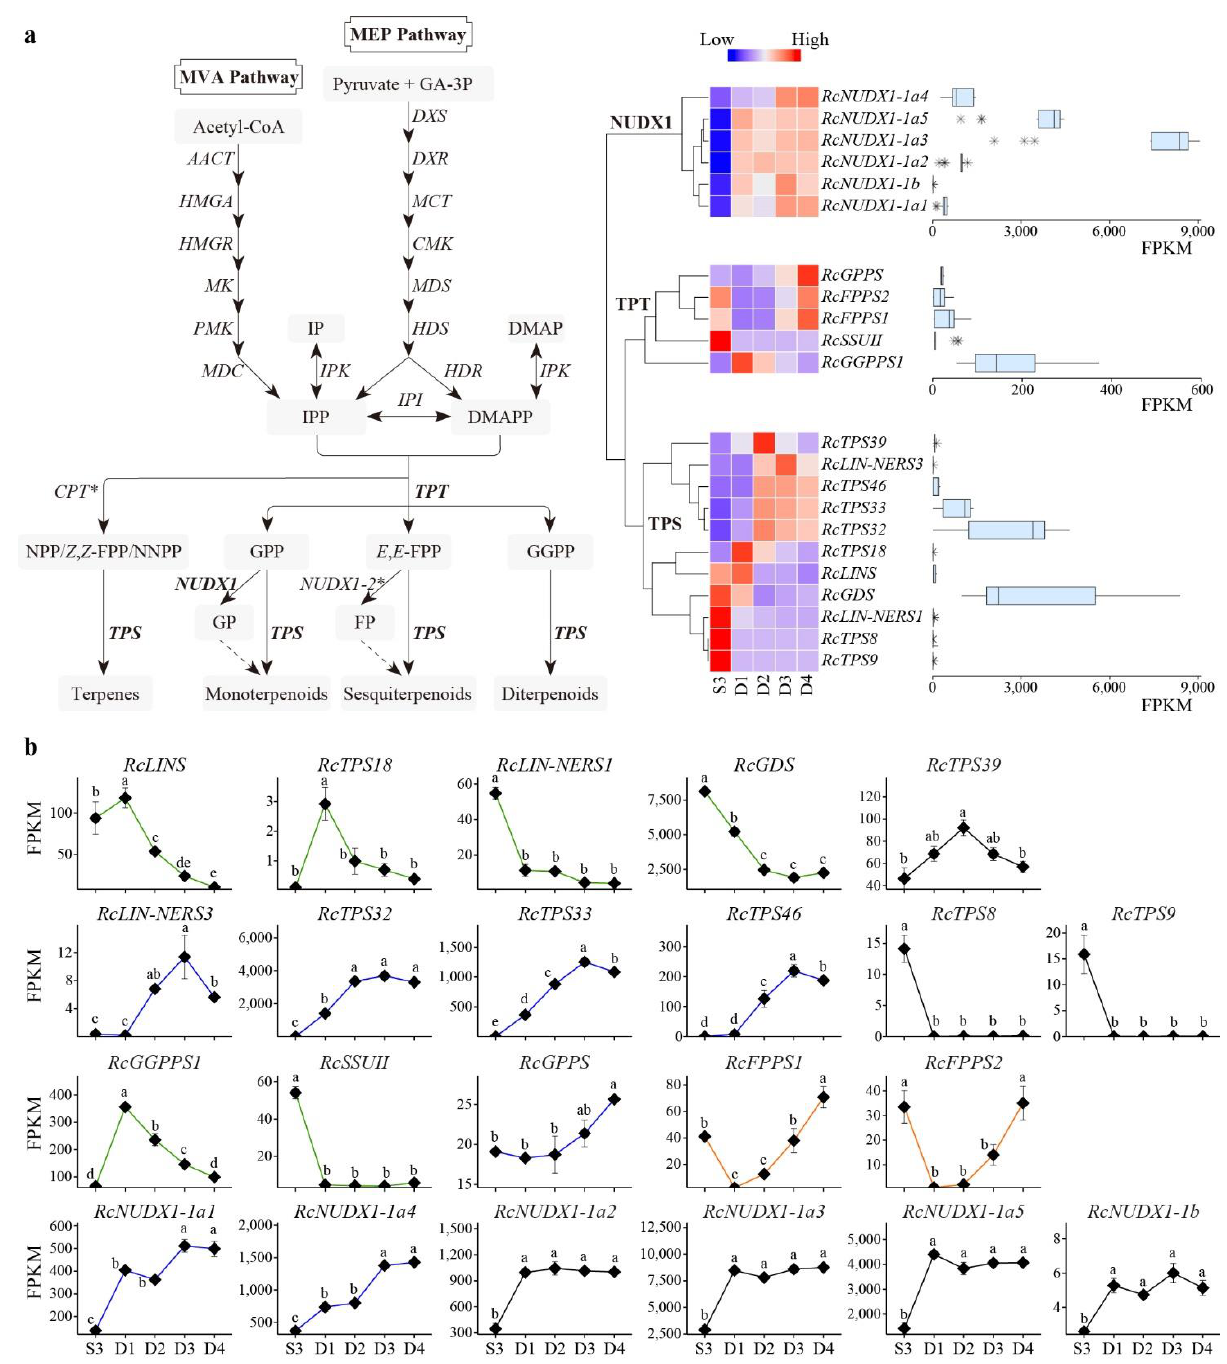
Figure 5. Expression profiles of RcTPSs , RcTPTs , and RcNUDX1 genes at different flower developmental stages. ( a ) Terpene biosynthesis pathways in rose [23,46] and expression levels of RcTPTs , and RcNUDX1 genes. The genes marked with asterisk (*) indicated that the average FPKM of all members of this family was less than 1 in five MU samples. Clustering_distance_rows ‘euclidean’, clustering_method ‘complete’. ( b ) The gene expression patterns in different MU samples. Bars represent the standard error ( n = 3). The genes with different expression patterns are illustrated in different colors. Different lowercase letters indicate statistically significant differences among samples at different developmental stages (ANOVA test, p <